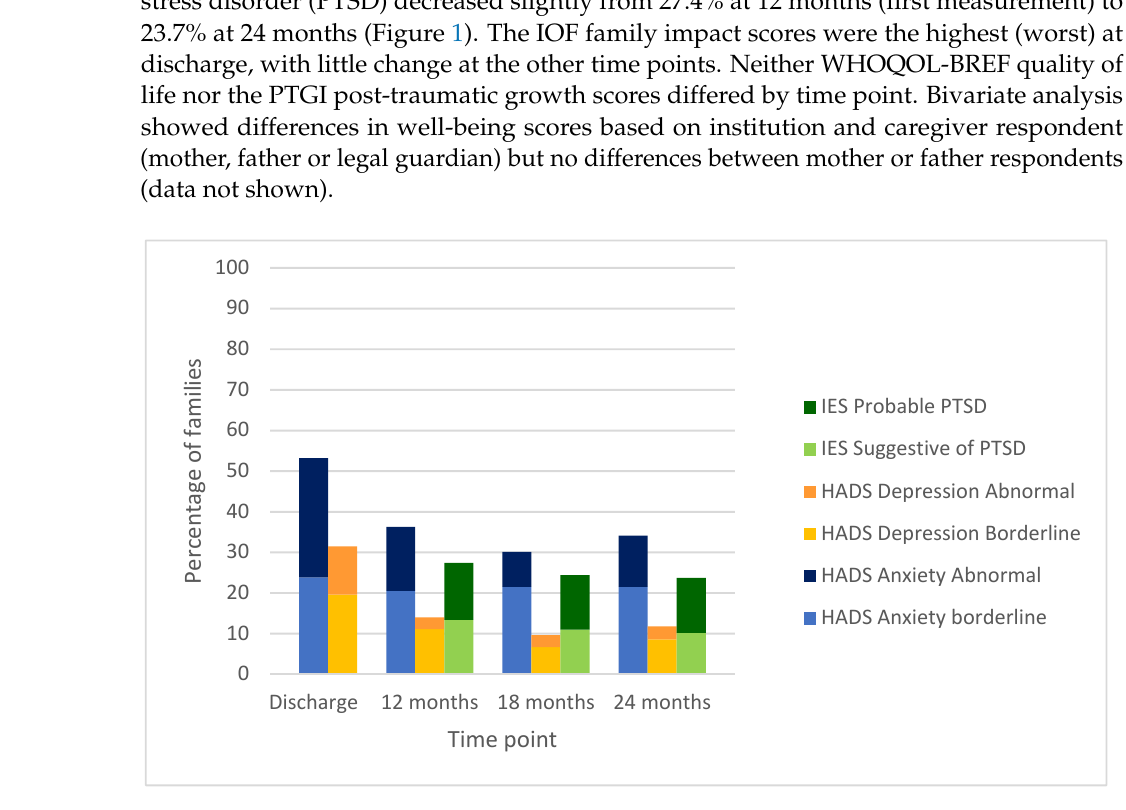
Figure 1. Depression, anxiety and post-traumatic stress symptoms over time for parents of neonates with acute symptomatic seizures.